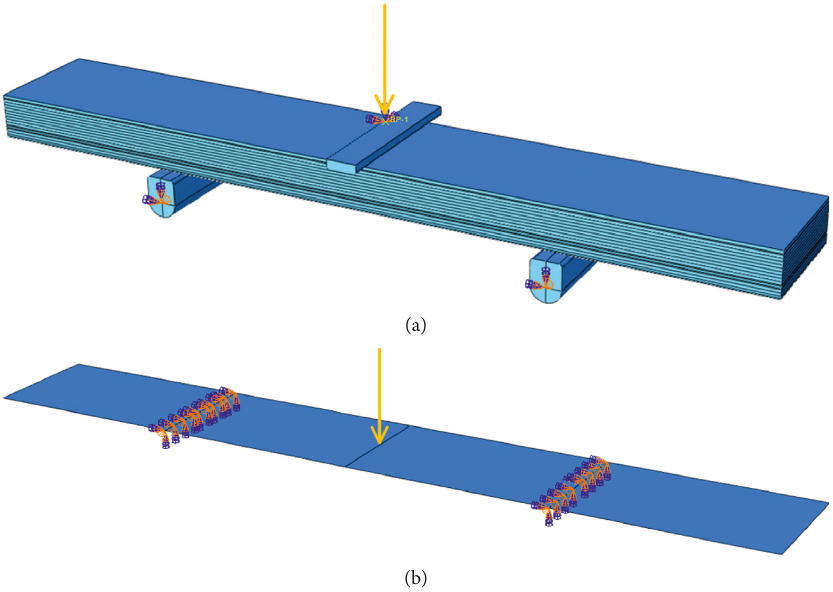
Figure 7: Loading simulation of floor model. (a) Multilayer mixed model. (b) Equivalent